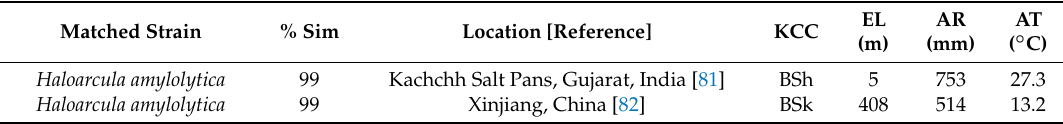
Table 1. Halophilic archaea isolates cultured from Great Salt Lake American White Pelican feathers. For each isolated cultivar, we have listed the closest-matched species/strain and percent similarity (% Sim) in the partial 16S rRNA gene sequence. For the sampling sites of matched strains, we have indicated the geographic location and reference for the study, Köppen Climate Classfication (KCC) [74], EL, Elevation Level (EL) in meters above sea level; Average Rainfall (AR), and Average Temperature (AT). DNA sequence information is available in the GenBank database, under accession numbers